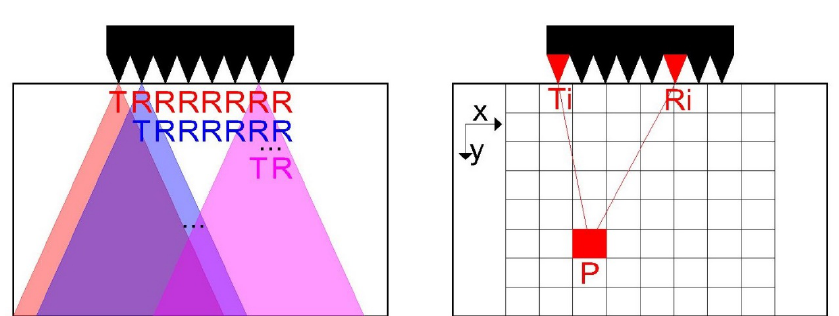
Figure 1. Data acquisition device’s operation mode (left) and geometry assumed for ultrasound imaging (right).